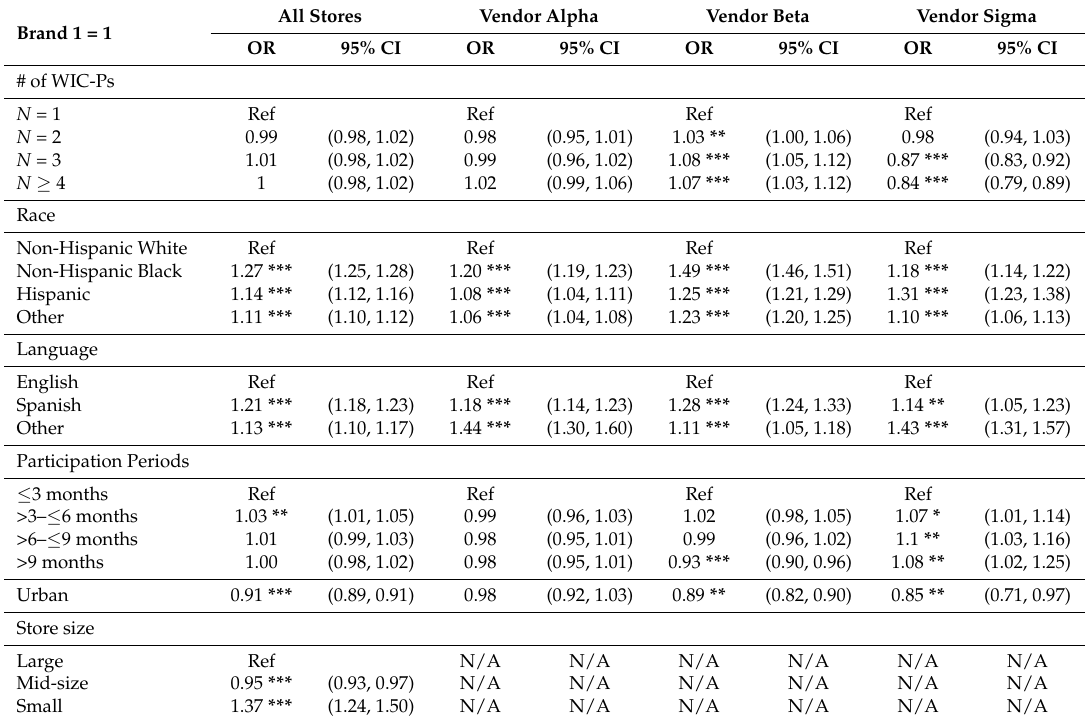
Table 3. Mixed effects logistic regression results of the selection of Brand 1 in infant fruits and vegetables among WIC participants in